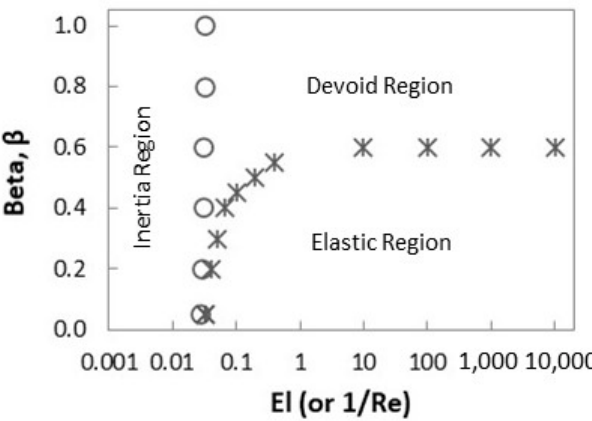
Figure 13. Phase space diagram, viscosity ratio versus elasticity number for Wi = 1.